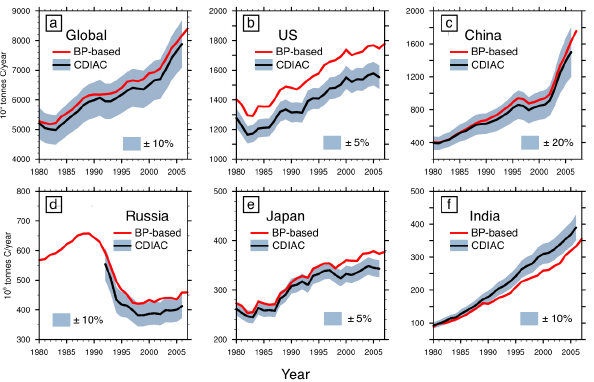
Fig. 3. Comparison of the historical global and national CO 2 emission estimates for the years 1980–2007. The red line shows the estimates given using BP (2008) in this study and black indicates CDIAC (Andres et al., 2009; Boden et al., 2009) estimates (excluding cement production and gas flaring). The shaded region shows error bounds for CDIAC taken from the literature. Values are given in units of Gigatonne carbon year − 1 .